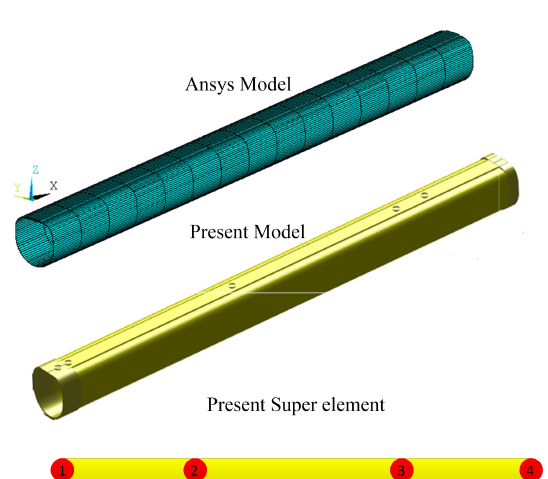
The vertical z -direction displacements and rotational angles around the y axis of the end nodes of the two models are cal- culated. The load displacements and rotational angles com- parison curves are shown in Fig.